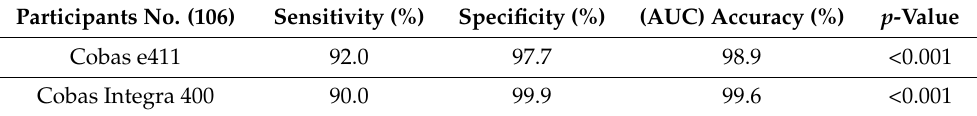
Table 4. Sensitivity, specificity, and accuracy of methods for serum ferritin measurement. Participants No.